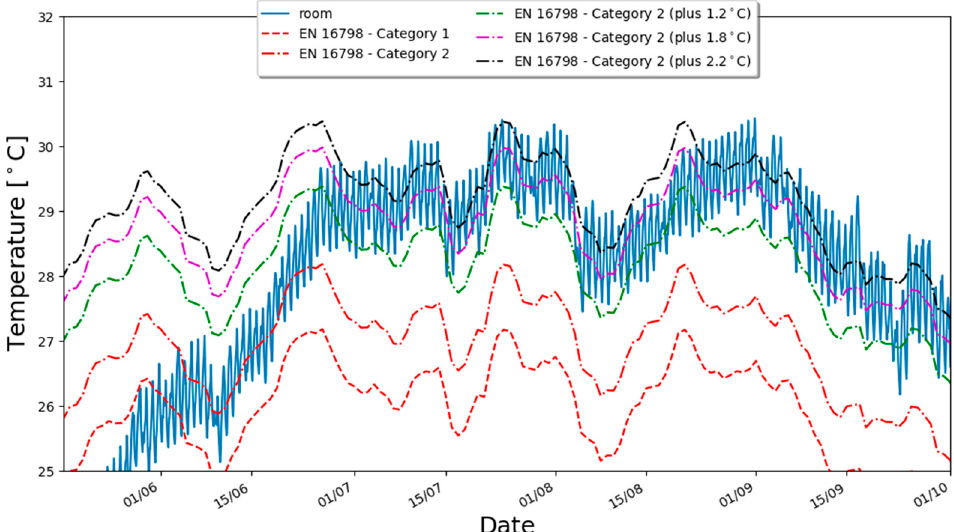
Figure 13. Temperature in the living room during the non-heating season with the category 2 limit extended to consider elevated air movement; very low-emitting configuration.